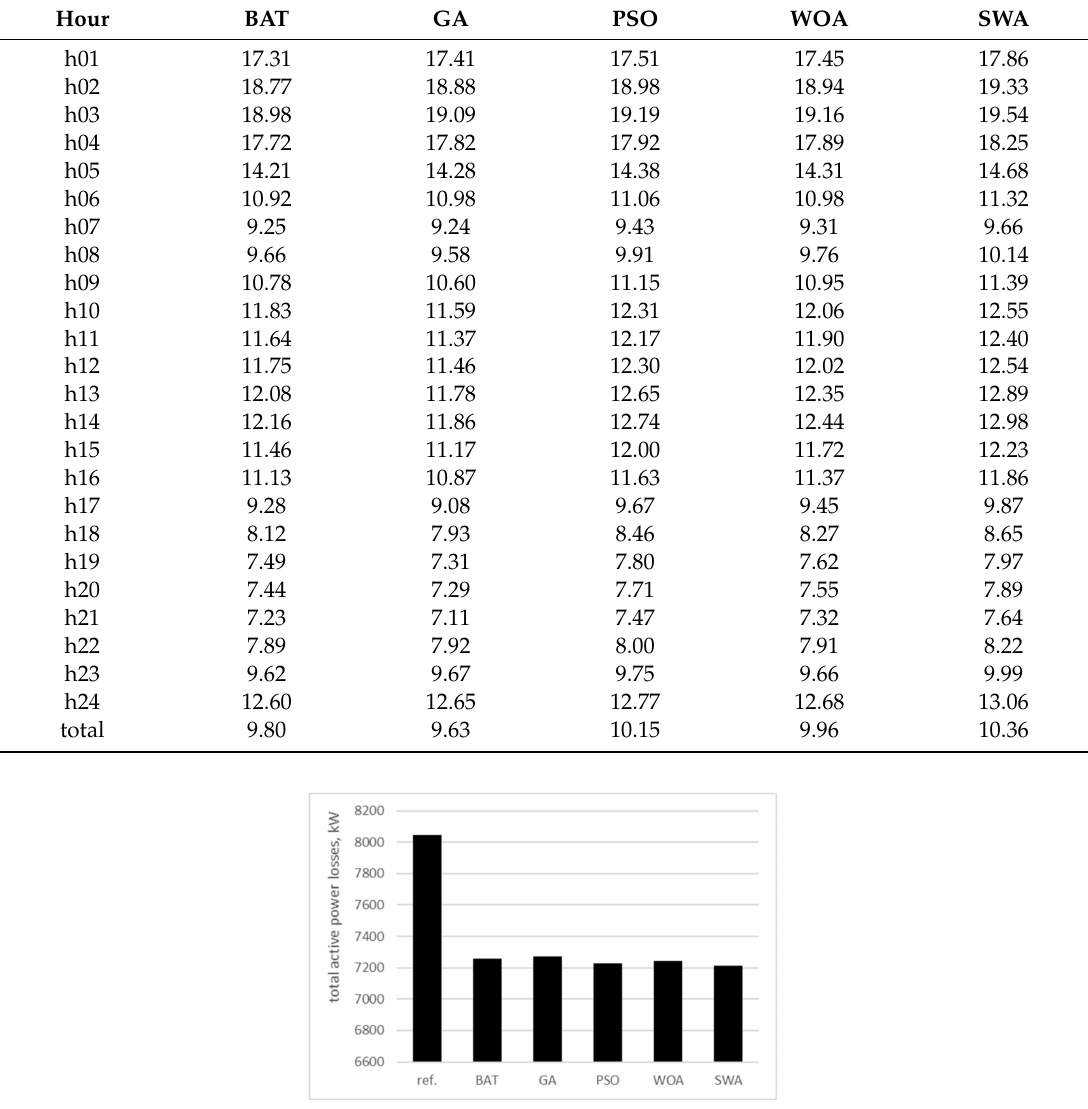
Figure 25. The total active power loss reduction in the 215-bus network, in kW, for each algorithm. The best CB allocation solution, obtained with the SWA, achieves a loss reduction of 833.91 kW or 10.36% for the entire network, in 24 h, which amounts to 304.38 MW in an entire year. The next